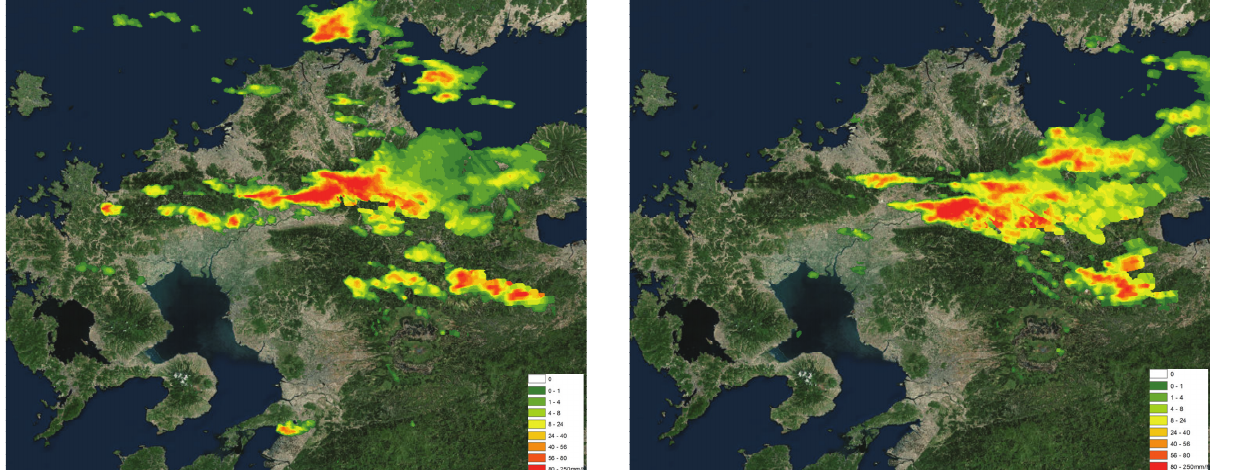
Figure 10. Result of inputting rainfall information of the X-band MP radar into GIS (2017.7.5 15:00).